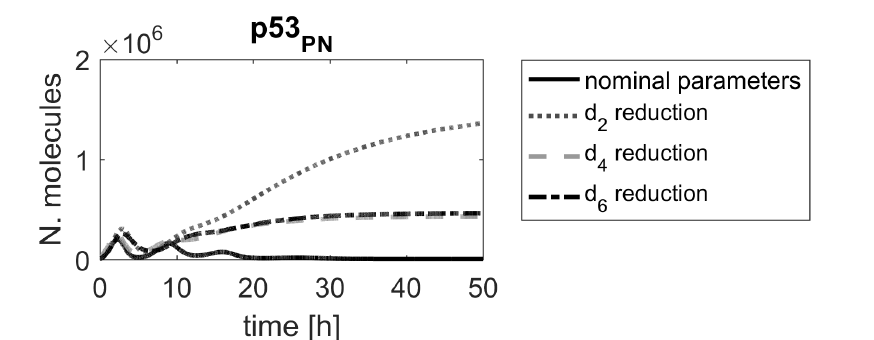
Figure 6. Comparison of p53 protein responses in the model with nominal parameters (black line) and parameters d 2 , d 4 and d 6 , reduced by α = 0.15 (gray dashed